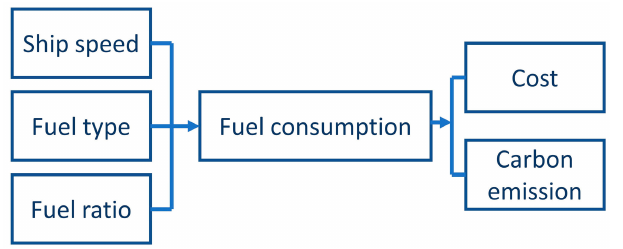
Figure 3. Process for evaluating the costs and carbon emissions of a dual-fuel ship. Table 2. Nomenclature and list of